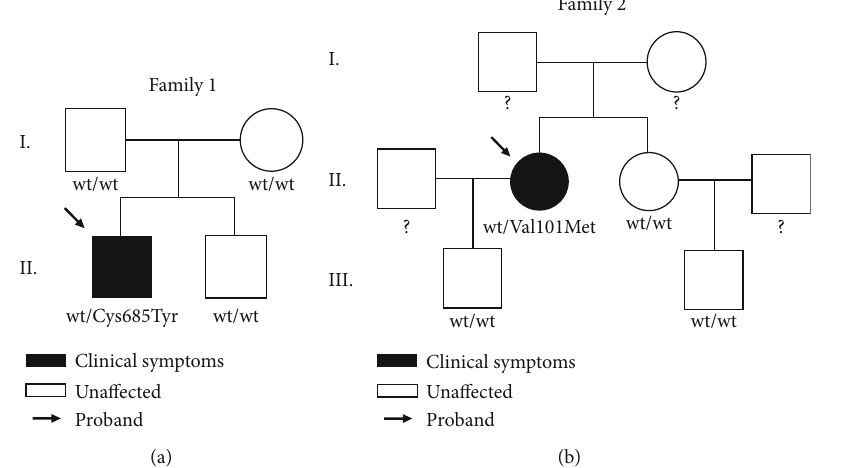
Figure 2: Pedigrees of families with ARAP3 variants. (a) Family 1: proband a ff ected with lymphedema carries an ARAP3 variant; three other una ff ected family members do not carry the variant. (b) Family 2: proband diagnosed with lymphedema and an ARAP3 variant. Three other una ff ected family members tested